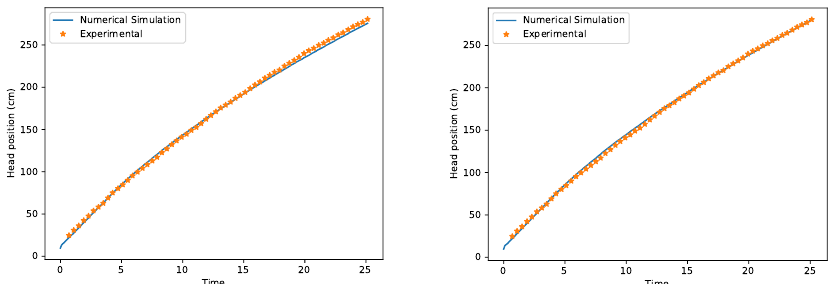
Figure 27. Evolution of the head of the gravity current over time. The left figure depicts the problem with M = 30 number of layers while the right shows the case with M = 40.